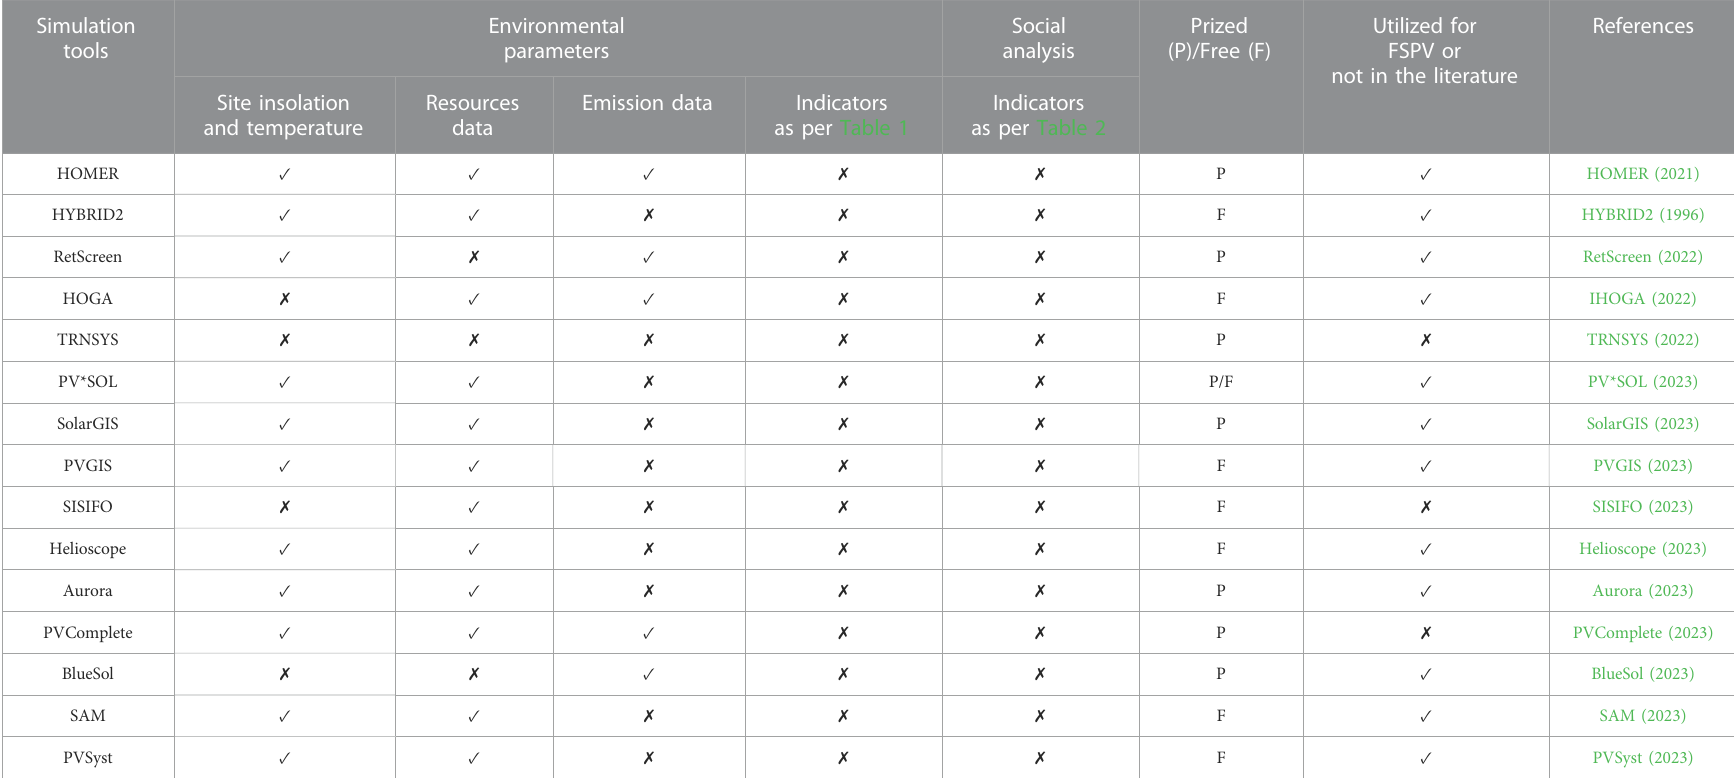
TABLE 6 A comparison of sixteen software illustrating the fundamental idea of important parameters and different analyses. Simulation